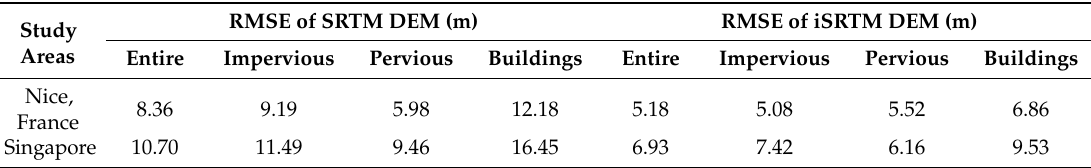
Table 3. The error patterns of SRTM DEM and iSRTM DEM in different land-uses.